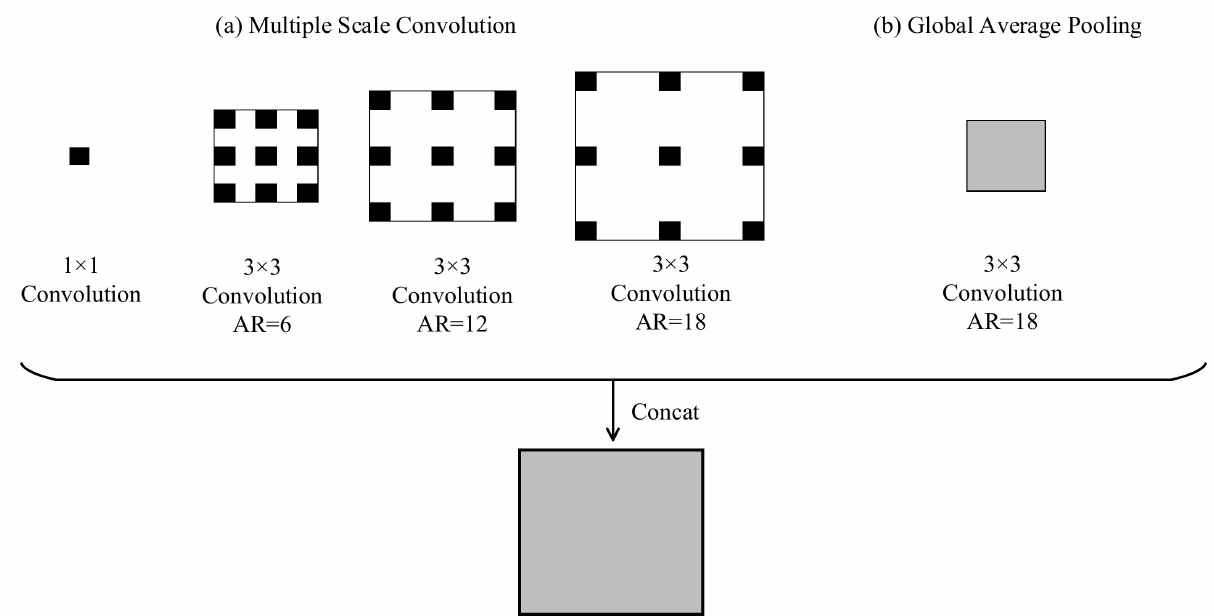
Figure 4. Atrous spatial pyramid pooling. ( a ) Multi-scale convolution, ( b ) global average